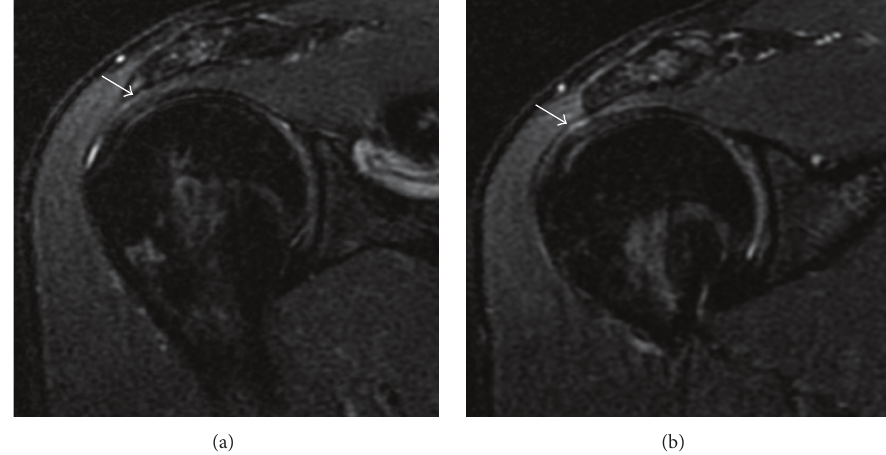
Figure 6: Coronal T2 FS SE MR images of the right shoulder (TR = 3500; TE = 63.2; NEX = 2; EC = 1) (a) and (b) showing the normal supraspinatus tendon long axis (white arrows), without tears.